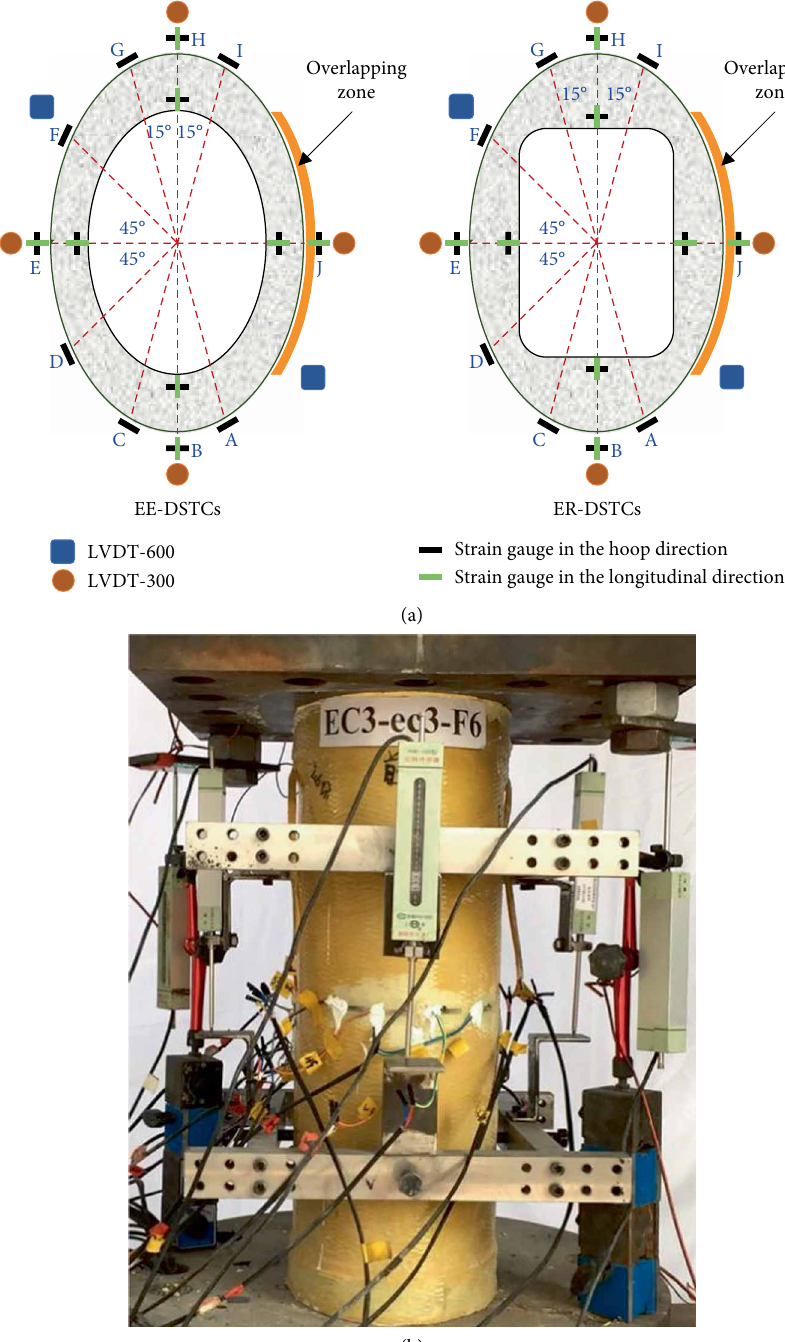
Figure 4: Experimental set-up and instrumentation. (a) Planar view of strain gauges and LVDTs. (b) Experimental